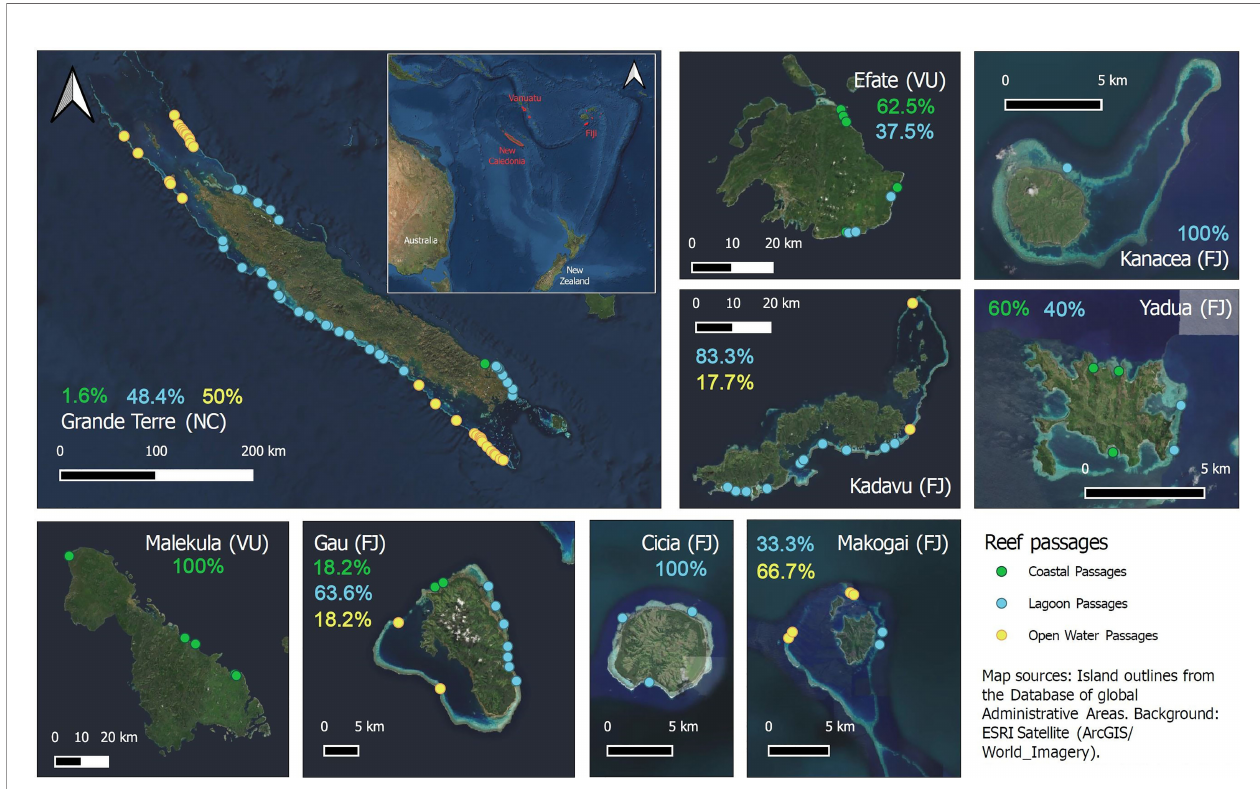
FIGURE 1 | Satellite images showing the locations of the three proposed reef passage types on the nine islands studied for this report, including their respective abundance for each of the islands; green=Type 1 ‘ Coast ’ , blue=Type 2 ‘ Lagoon ’ , yellow= Type 3 ‘ Open Water ’ , in New Caledonia (NC), Vanuatu (VU), and Fiji